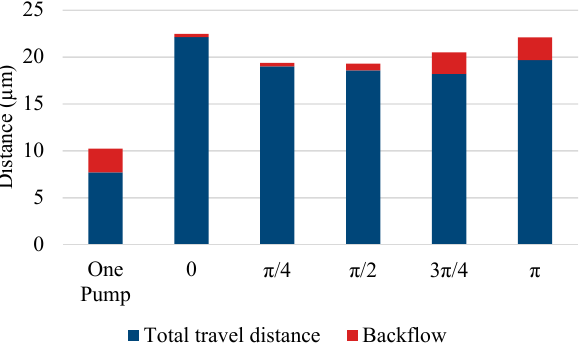
Figure 13. Experimental result of the series pump (pressure: 0.15